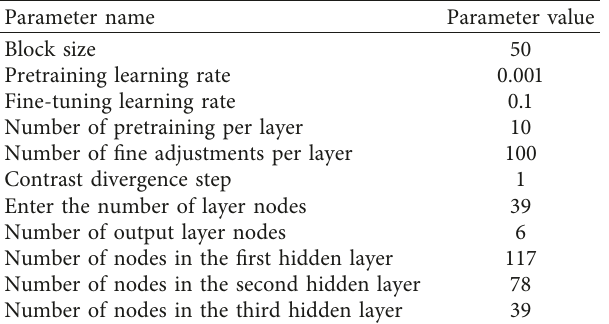
Table 7: DBN network parameters for identification and classi- fication of traditional Chinese musical instruments.